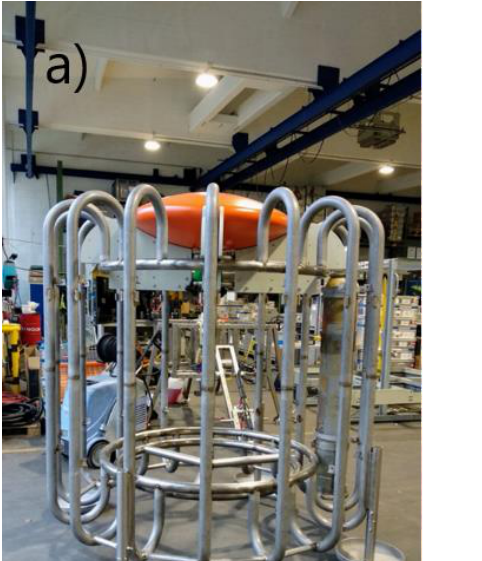
Figure 3. The bottom unit X-Net® (Metas AS, Bergen, Norway) includes a bottom-based permanent cable connected docking station X-Node (green; see also Figure 2) and an instrumented exchangeable top unit (X-Frame; yellow) that can be launched and recovered with the Launch Recovery Tool (X- LRT). Note that the ARIM X-Frame includes the garage for the crawler (see Figure 2). This allows the user to operate and maintain the ARIM system without the assistance of expensive ROV vessel time.